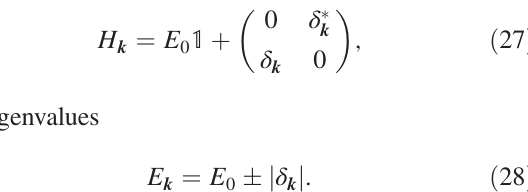
FIG. 7. Band structure of skyrmions in a triangular lattice induced by skyrmion-antiskyrmion tunneling of strength δ . The band structure depends sensitively on the number of flipped spins N f forming the skyrmion and antiskyrmion bound state. For N 0 mod 3 the band minimum is at the Γ point while Dirac f ¼ points are located at the K points. For N f ¼ 1 mod 3 the band minimum is located at the K point and a quadratic band touching occurs at the Γ point. See Fig. 8 for N f ¼ 2 mod 3